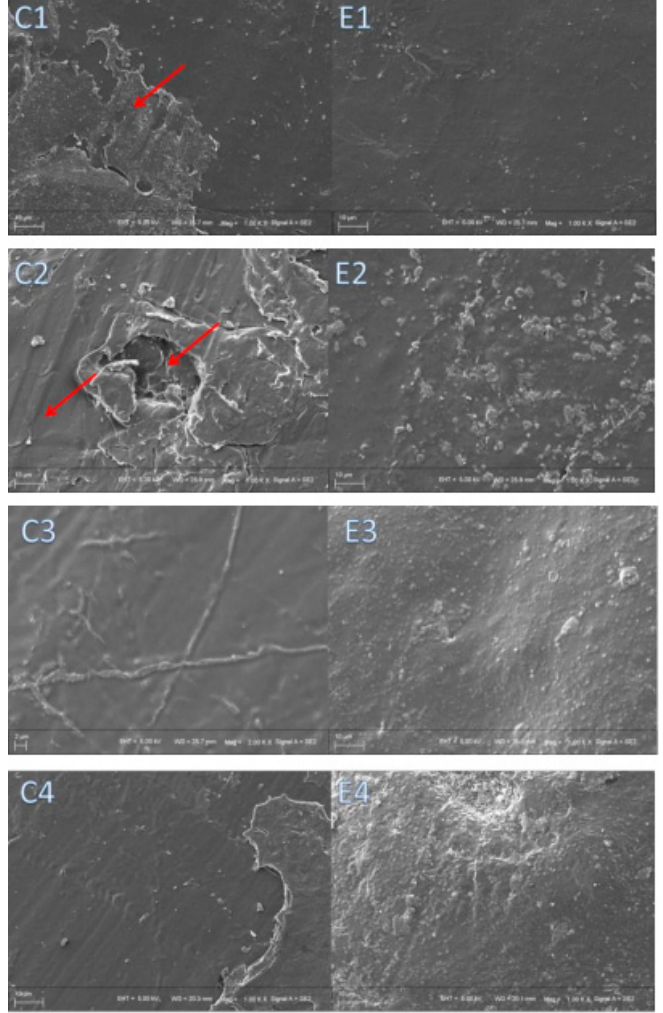
Figure 12. SEM images of the PLLA rod (( C1 ), ( C2 ), ( C3 ), ( C4 )) and PLLA1 (( E2 ), ( E2 ), ( E3 ), ( E4 )) rod after implantation for 4, 8 ,12 and 24 weeks.